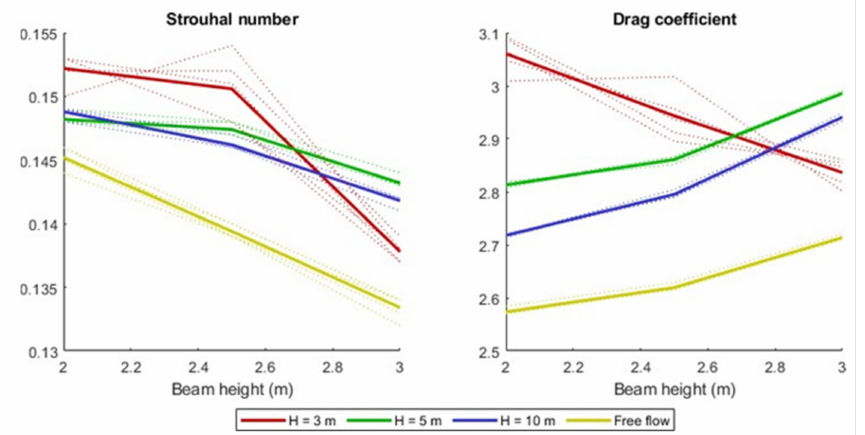
Figure 5. Values of the Strouhal number and drag coefficient extracted from the simulations with one beam. The dotted lines represent the results for a particular wind speed, while the continuous lines are the average values from all the wind speeds (double column, B&W in the printed version).